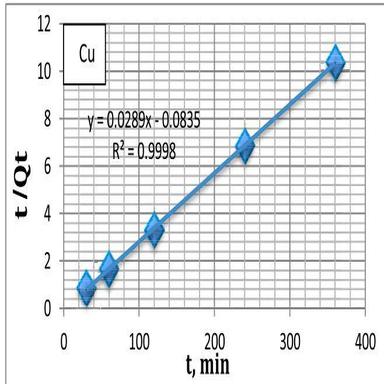
Plot of pseudo-second order reaction for adsorption of heavy metals by SiO2@C nanocomposite (SC1).